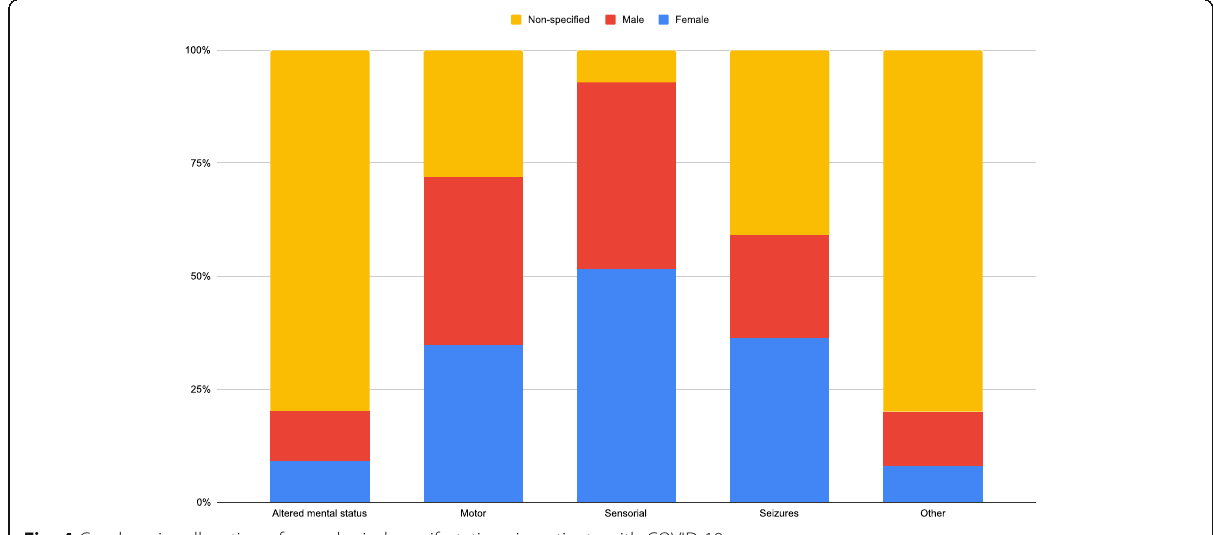
Fig. 4 Gender wise allocation of neurological manifestations in patients with COVID-19